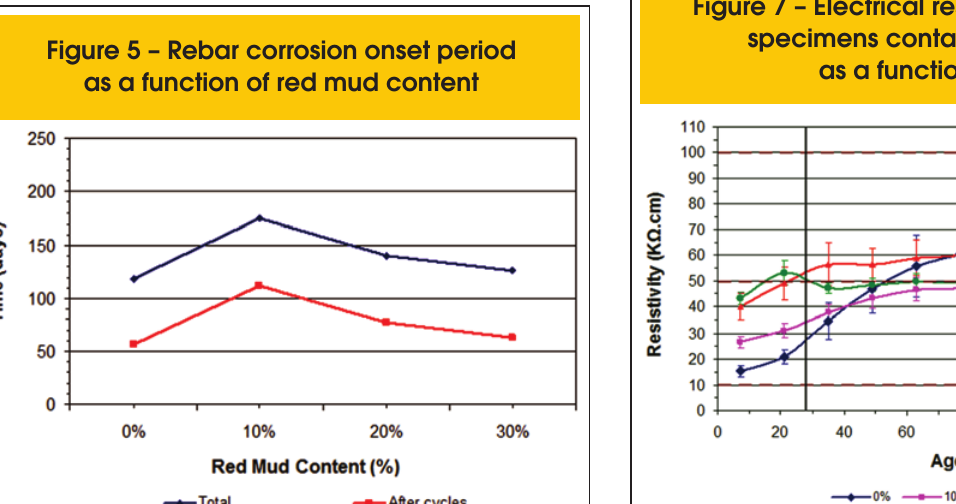
Figure 7 – Electrical resistivity of concrete specimens containing red mud, as a function